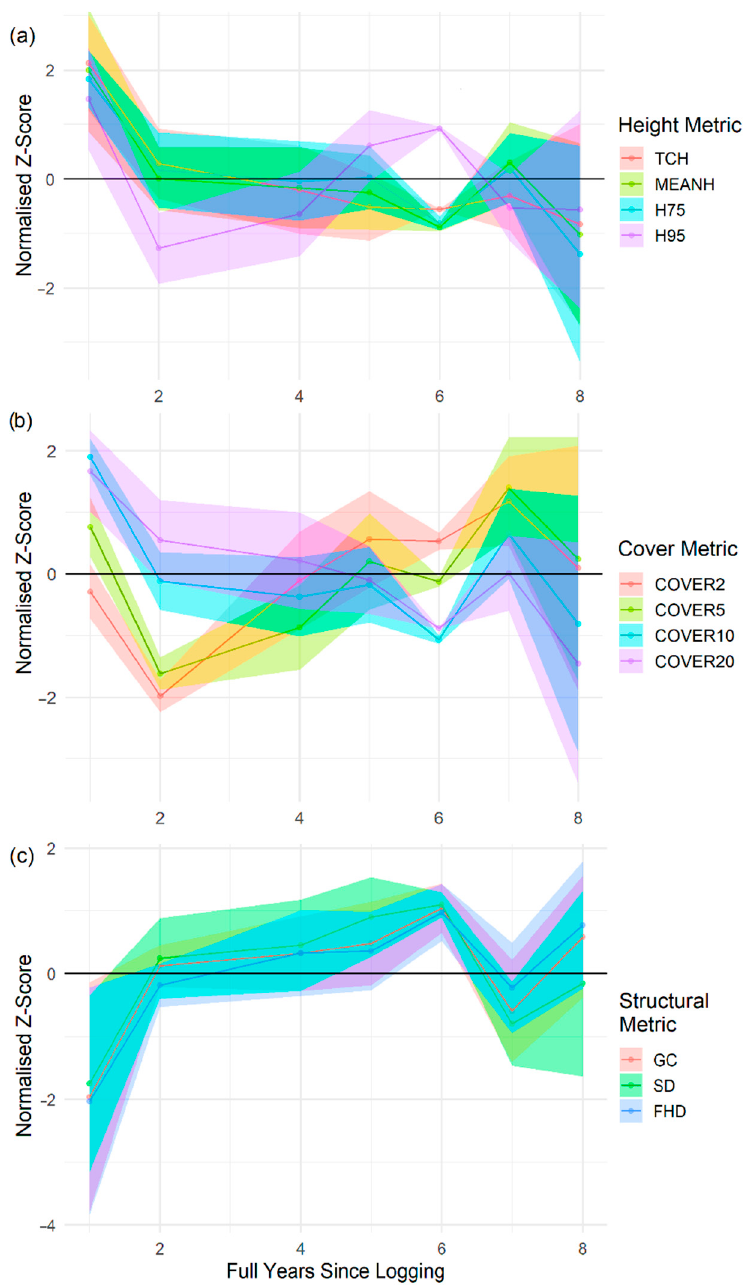
Figure 4. Graphs of the temporal dynamics of LiDAR metrics in the years after selective logging for each of the EMTs, normalised using Z-score for comparison between metrics. ( a ) EMT—height, TCH—top of canopy height, MEANH—mean height, H75 and H95—75th and 95th percentiles of height. ( b ) EMT—cover: COVER2, 5, 10, and 20 are the percentage cover at height thresholds of 2, 5, 10, and 20 m, respectively. ( c ) EMT—structural complexity, GC—Gini coefficient, SD—standard deviation of height, FHD—foliage height diversity.